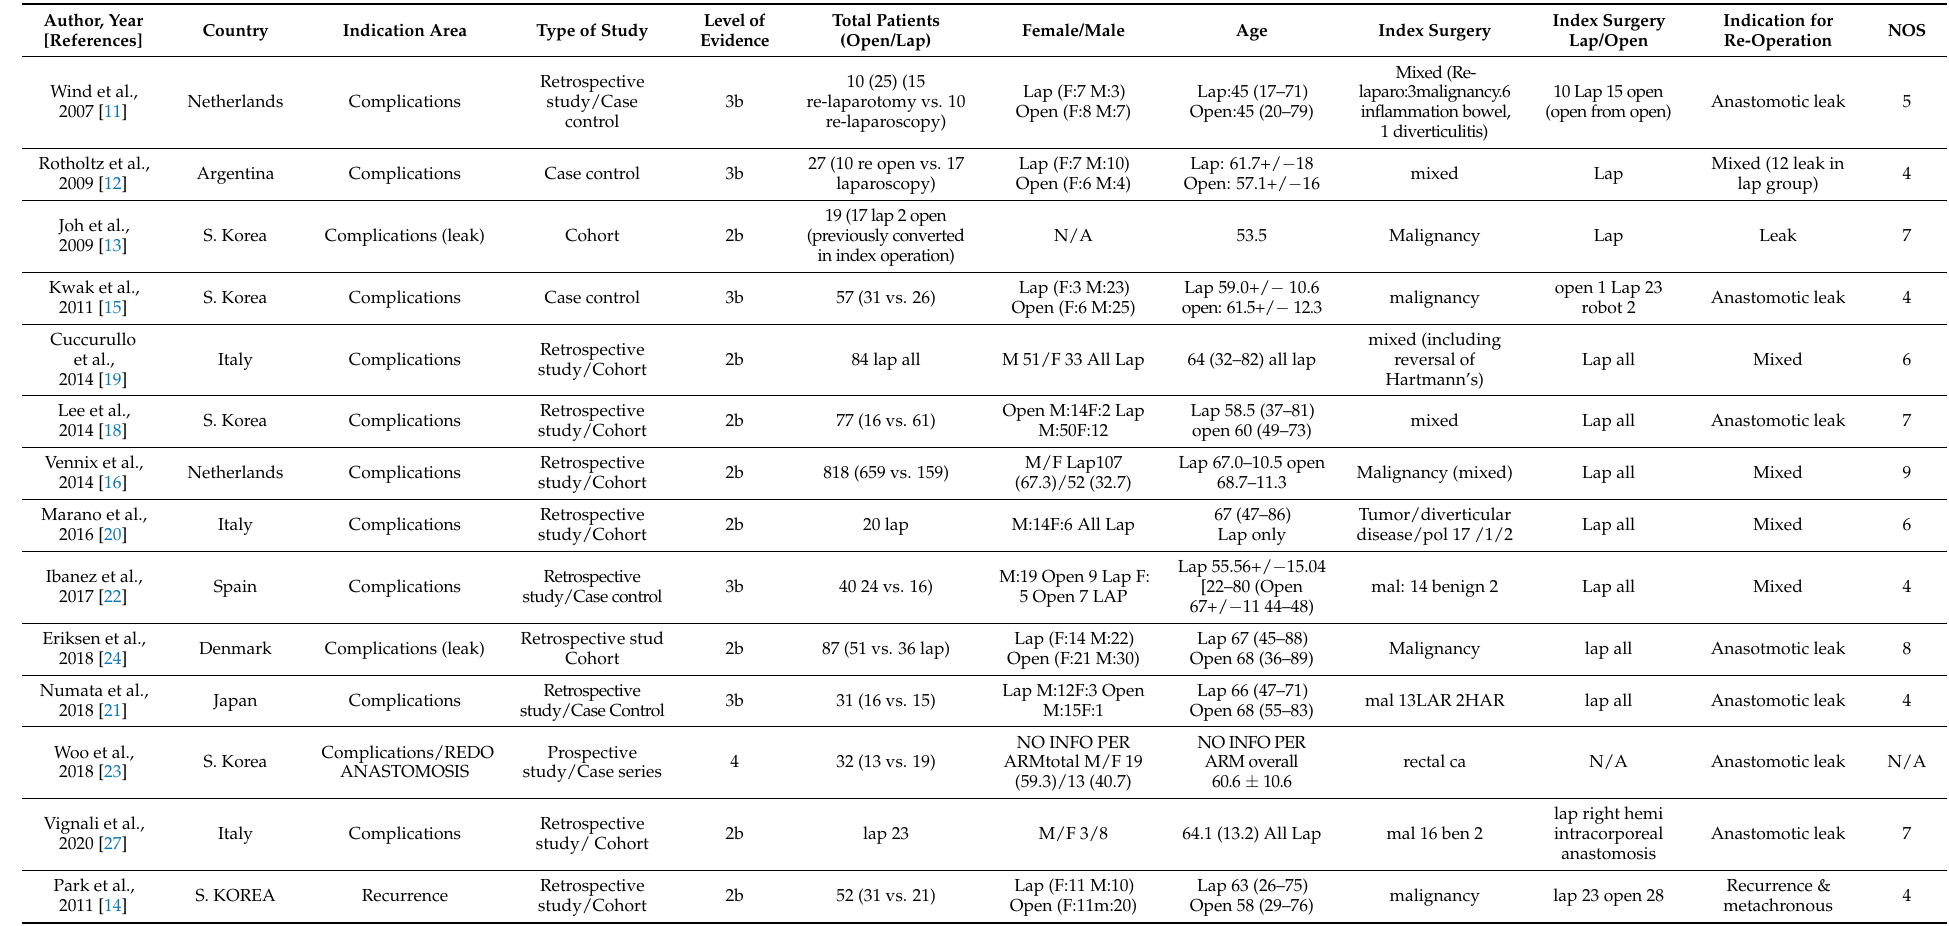
Table 1. Patient